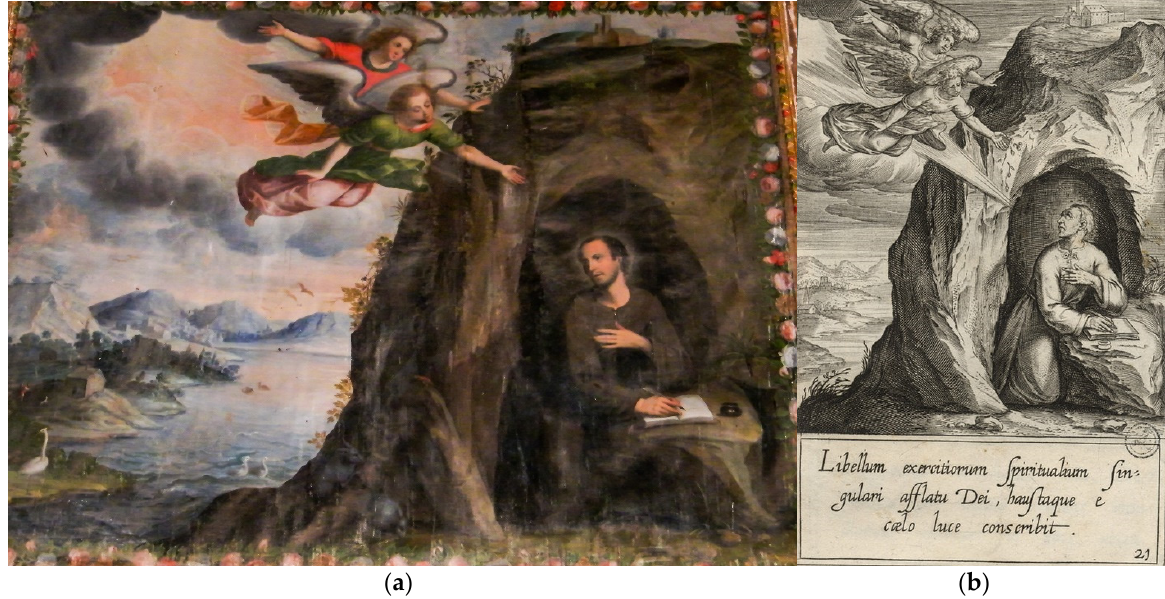
Figure 5. ( a ) Unidentified Cuzco artist, Saint Ignatius Composes the Spiritual Exercises at Manresa, 17th century, oil on canvas, Iglesia de San Pedro, Juli, Puno, Peru. Credit line: Sebastian Ferrero ( b ) Jean Baptiste Barbé, Saint Ignatius Composes the Spiritual Exercises at Manresa, 1609, etching and engraving, Plate 21 of the Vita beati P. Ignatii Loyolae, Societatis Jesu fundatoris, with Latin texts by N. Lancicius . Credit line: Portugal National Library from PESSCA (Project on the Engraved Sources of Spanish Colonial Art).